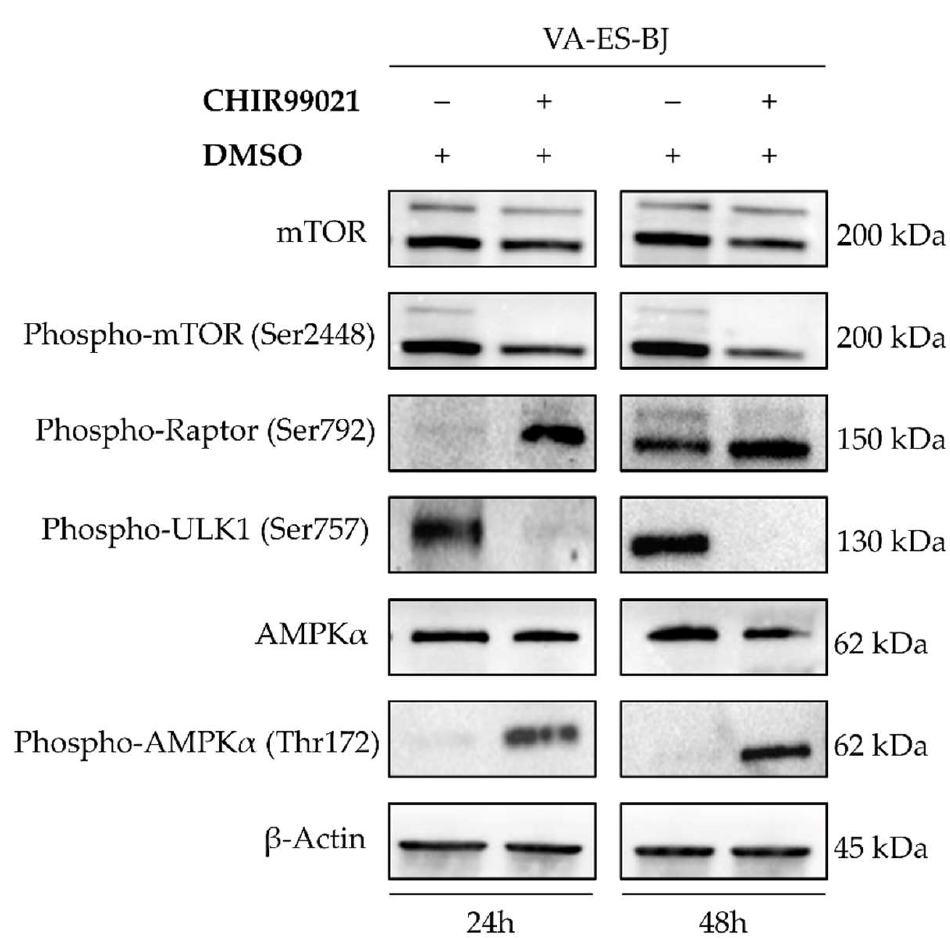
Figure 7. CHIR99021 promotes autophagy through AMPK/mTORC1/ULK1 axis. Western blots showing levels of specific autophagy markers in VA-ES-BJ cells measured at 24 and 48 h after exposure to CHIR99021 100 µM. The blot was first incubated with anti-mTOR, anti-phospho-mTOR, anti-phospho-RAPTOR, anti-AMPK, anti-phospho-AMPK, anti-phopho-ULK1 and then reprobed with anti-β-Actin to confirm the equal loading of each lane (60 µg of whole lysate).